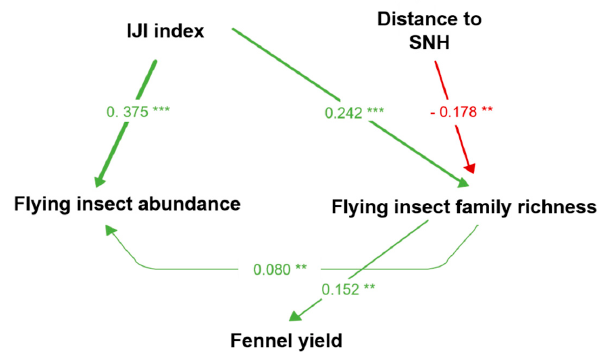
Figure 1. Path diagram of the structural equation modelling showing the drivers of fennel insect communities and yield (Fisher’s C = 10.575, k = 8, p > 0.05). The width of arrows depends on effect’s size. *** p < 0.001; ** p < 0.01. (Arrow color helps visualize the sign of the effect, green: positive effect; red: negative effect). See Appendix D for details of the path-analysis settings. Table 1. Path coefficients of the structural equation modelling showing the drivers of fennel insect communities and yield (Fisher’s C = 10.575, k = 8, p > 0.05). *** p < 0.001; ** p < 0.01. Crit. Response Predictor Estimate Std. Error DF p . Value Value